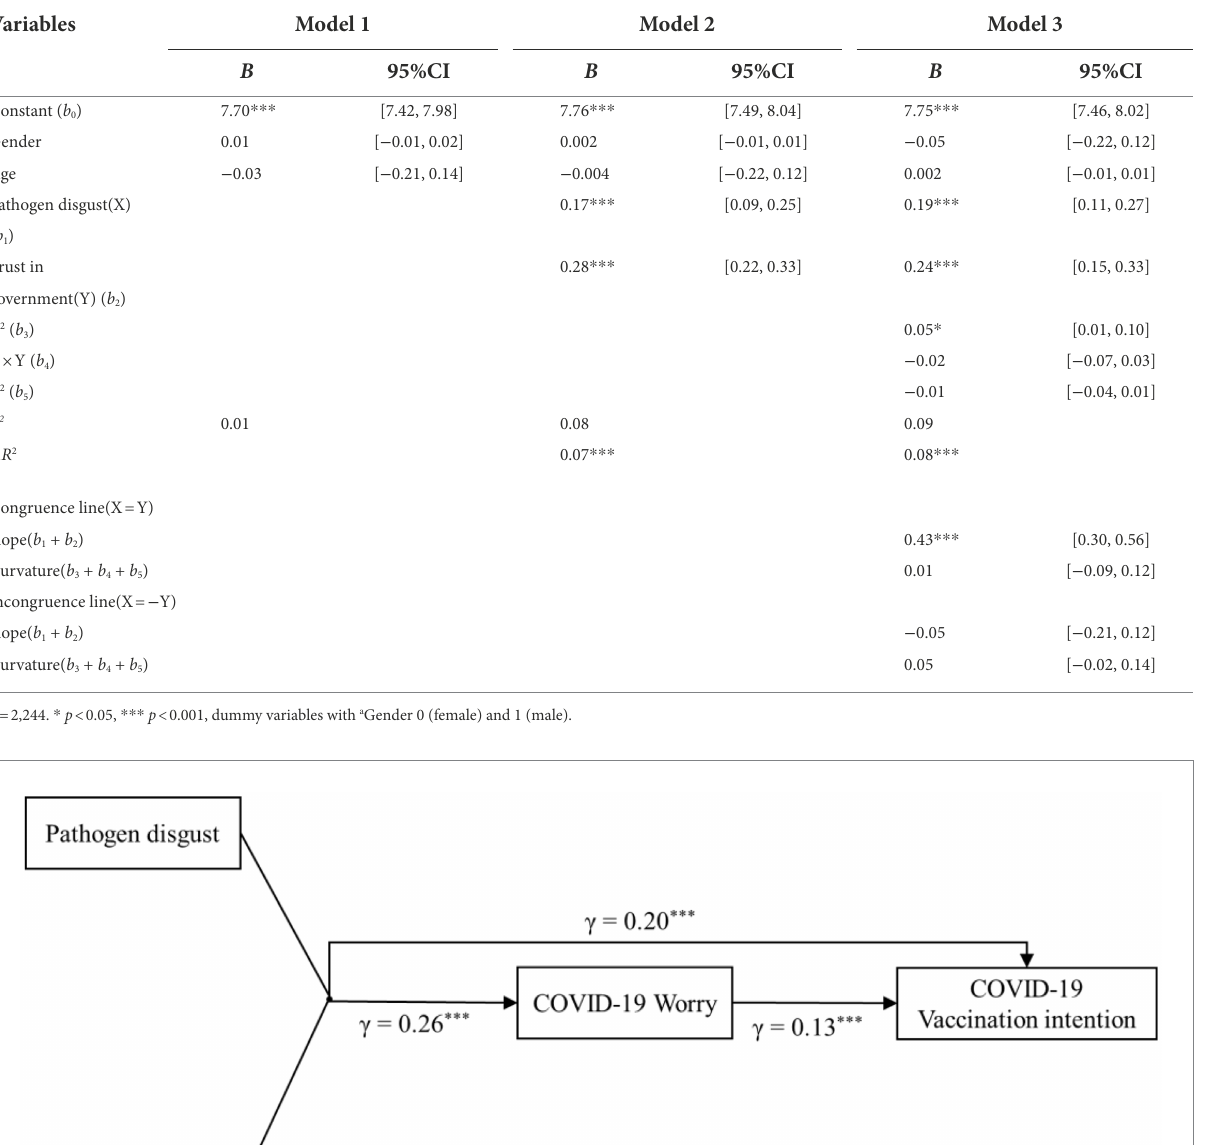
TABLE 3 Polynomial regression results.